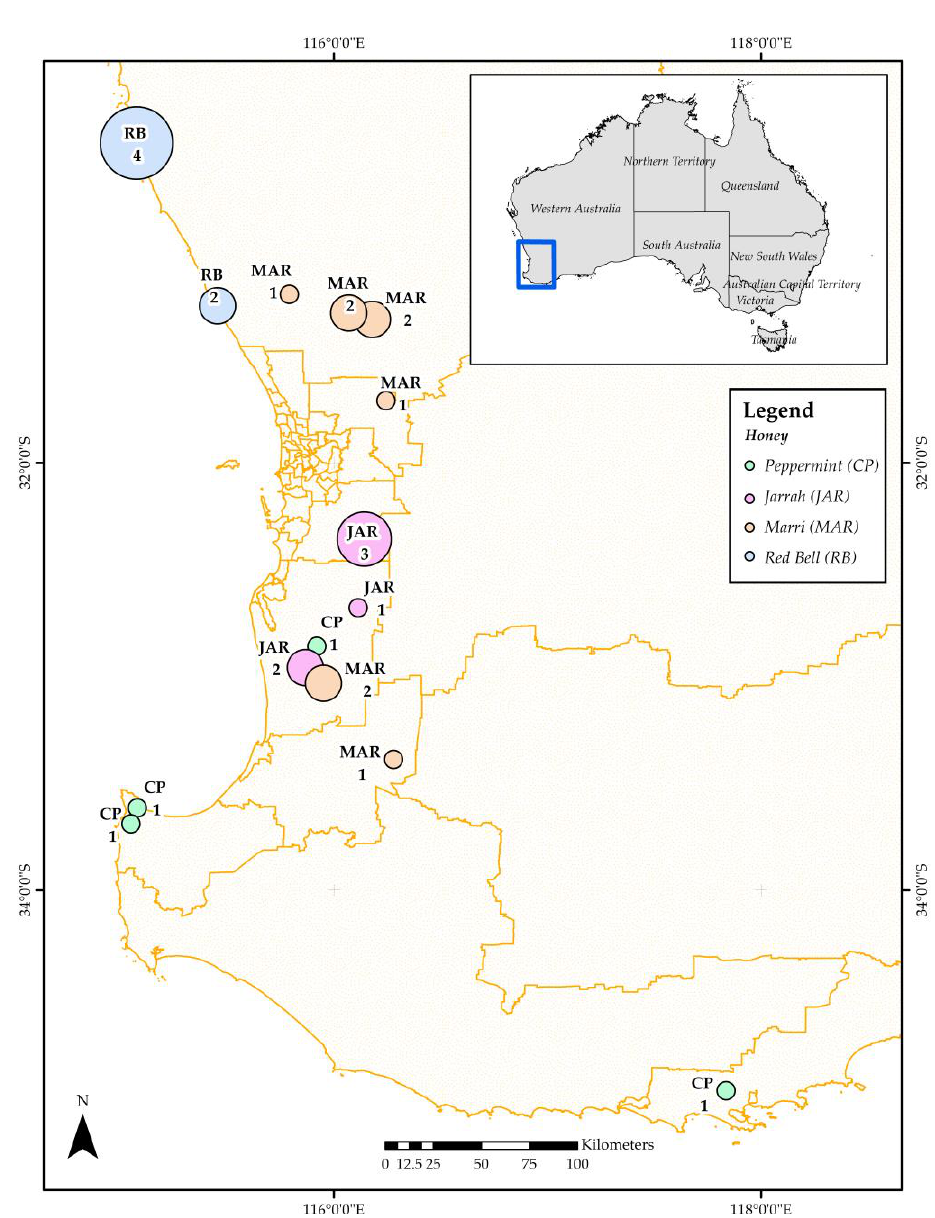
Figure 1. Collection sites of honeys used in this study (samples shown for which this information was available). Map generated using ARCGIS Version 10.8. Redlands, CA, USA (Note: Numbers correspond to the number of samples of honey collected from each specific location; Source: https://www.abs.gov.au/statistics/standards/australian-statistical-geography-standard-asgs-edition-3/jul2021-jun2026/access-and-downloads/digital-boundary-files, accessed on 10 November 2022).